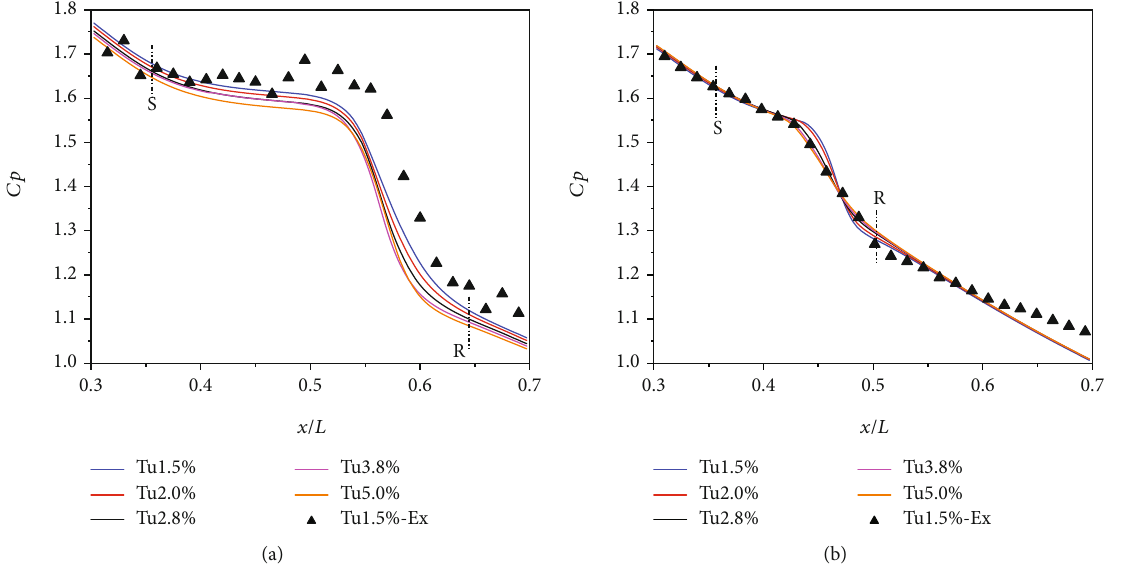
fi xed (a) Re150000 and (b) Figure 10: C p comparison with